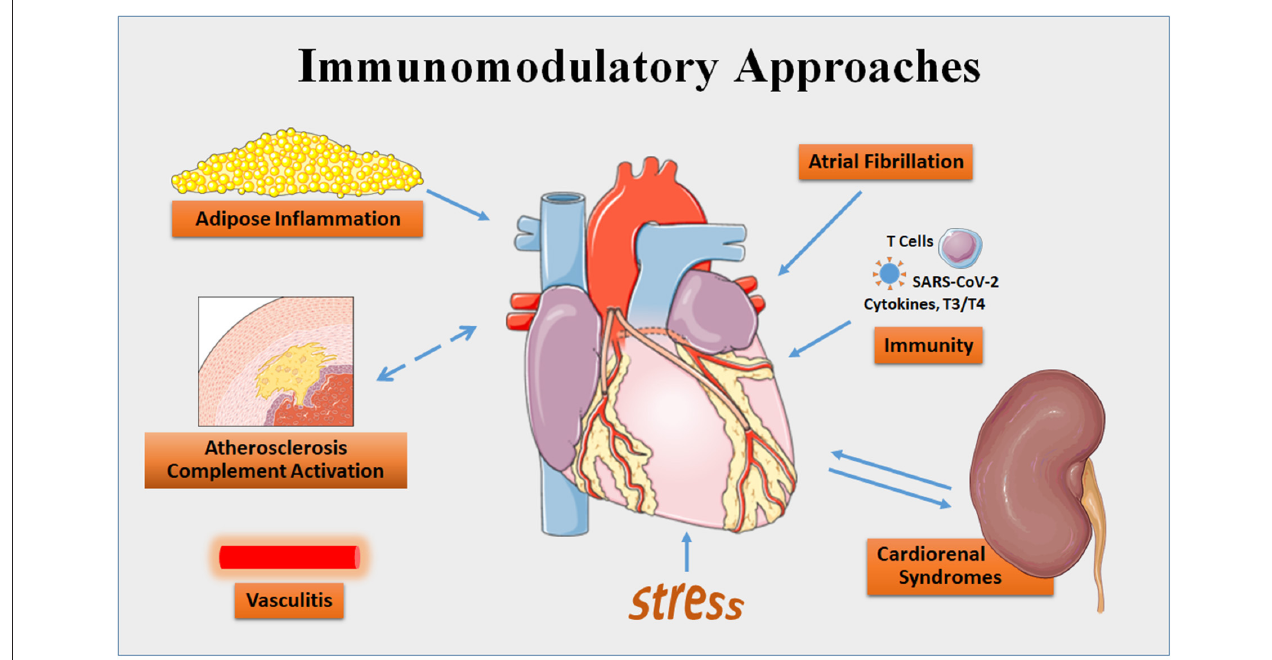
FIGURE 1 | Areas of cardiovascular disease targeted by immunomodulatory approaches that are covered by the series in Frontiers in Cardiovascular Medicine. Some content is adapted from Servier Medical Art